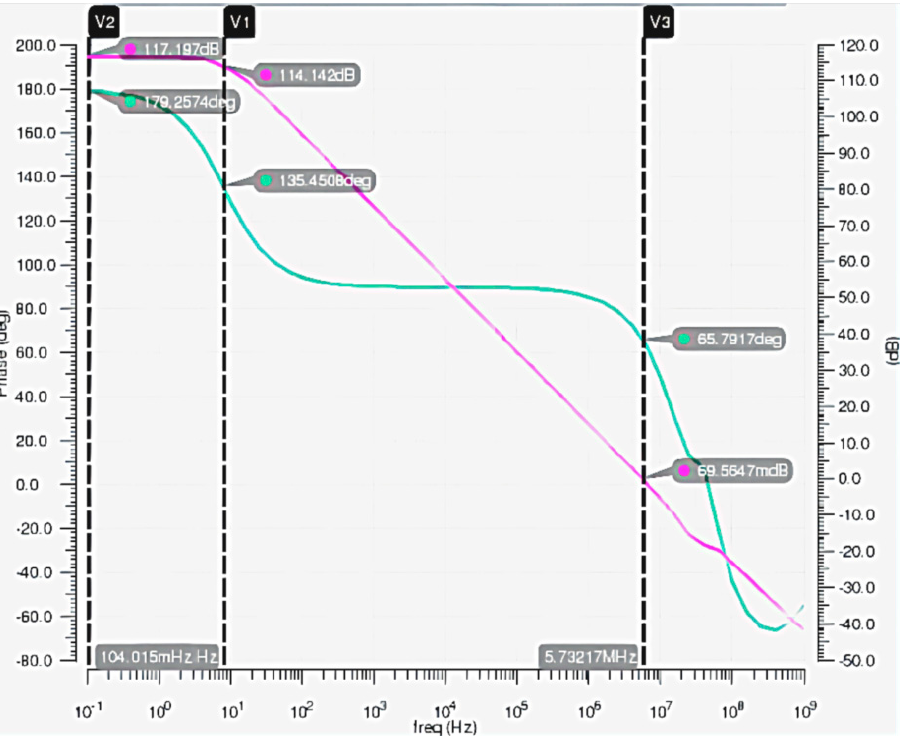
Figure 10. The AC simulation of the post amplifier.